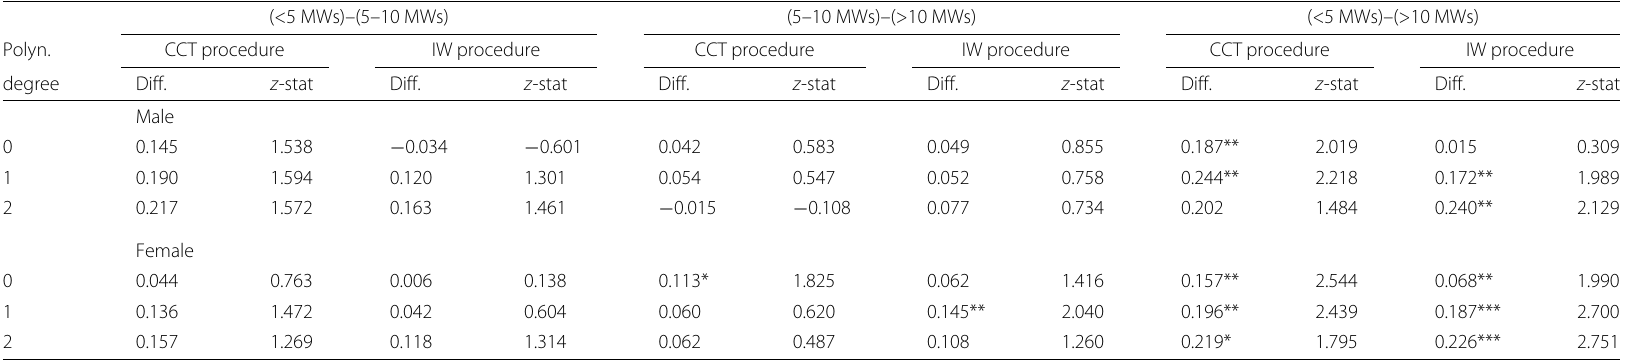
Table 10 Differences in RD estimates of test scores by household